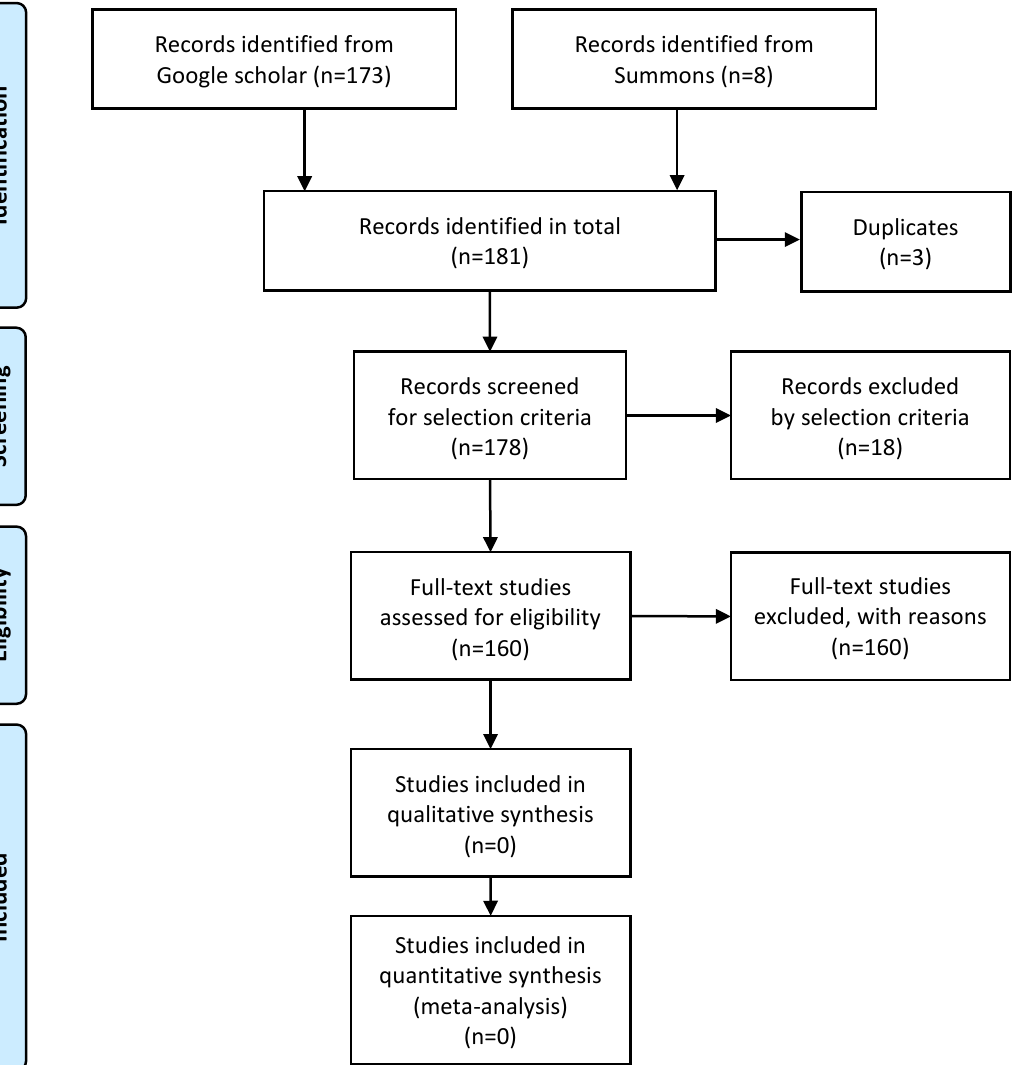
Figure 1. Selection process of identified studies following the PRISMA